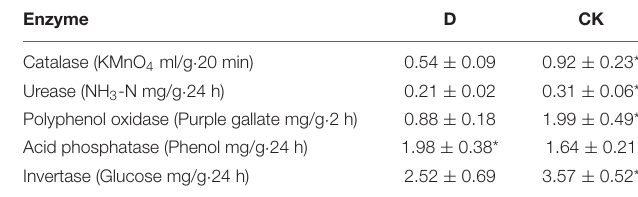
TABLE 1 | The properties of garlic plants grown in cropping obstacle soil (D) and healthy control soil (CK). Item tested